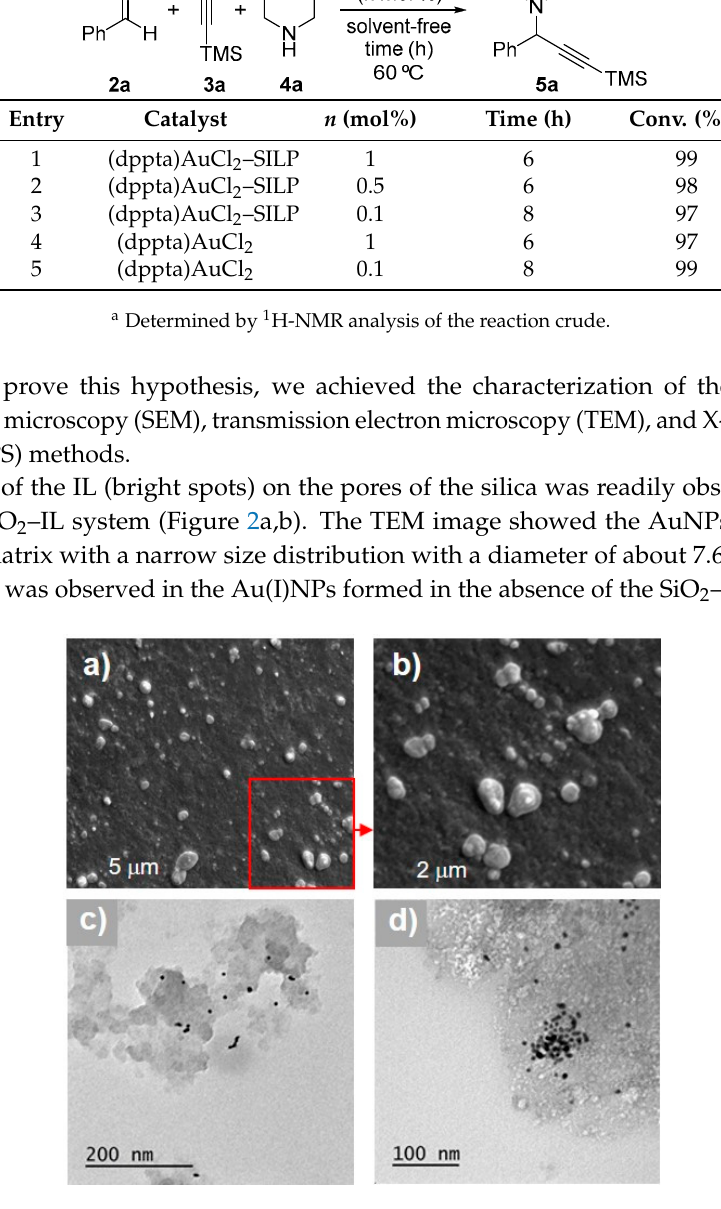
Figure 2. Scanning electron microscopy (SEM) ( a , b ) and transmission electron microscopy (TEM) ( c , d ) images of AuNPs formed in the A 3 synthesis of 5a in the presence of 0.1 mol% of (dppta)AuCl 2 –SiO 2 –[bmim]PF 6 under solvent-free conditions.